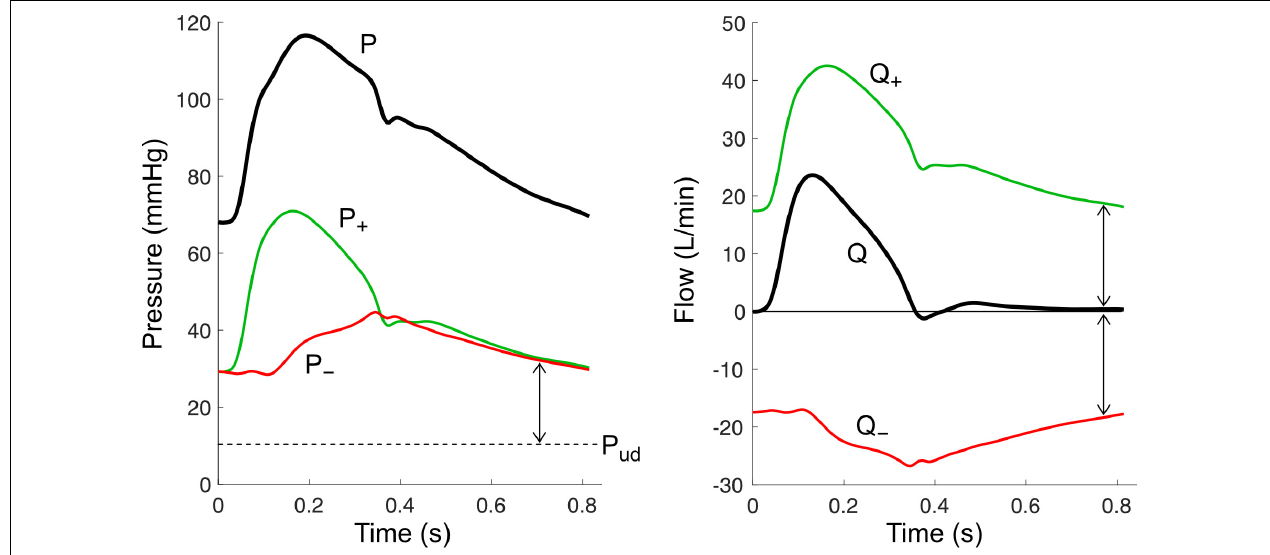
FIGURE 4 | Wave separation analysis for pressure (P) and flow (Q) signals. Forward components (P + and Q + ) and backward components (P − and Q − ) are calculated using the equations in Table 1 , with an assumed undisturbed pressure ( P ud ) of 10 mmHg. Arrows indicate wave potential at that